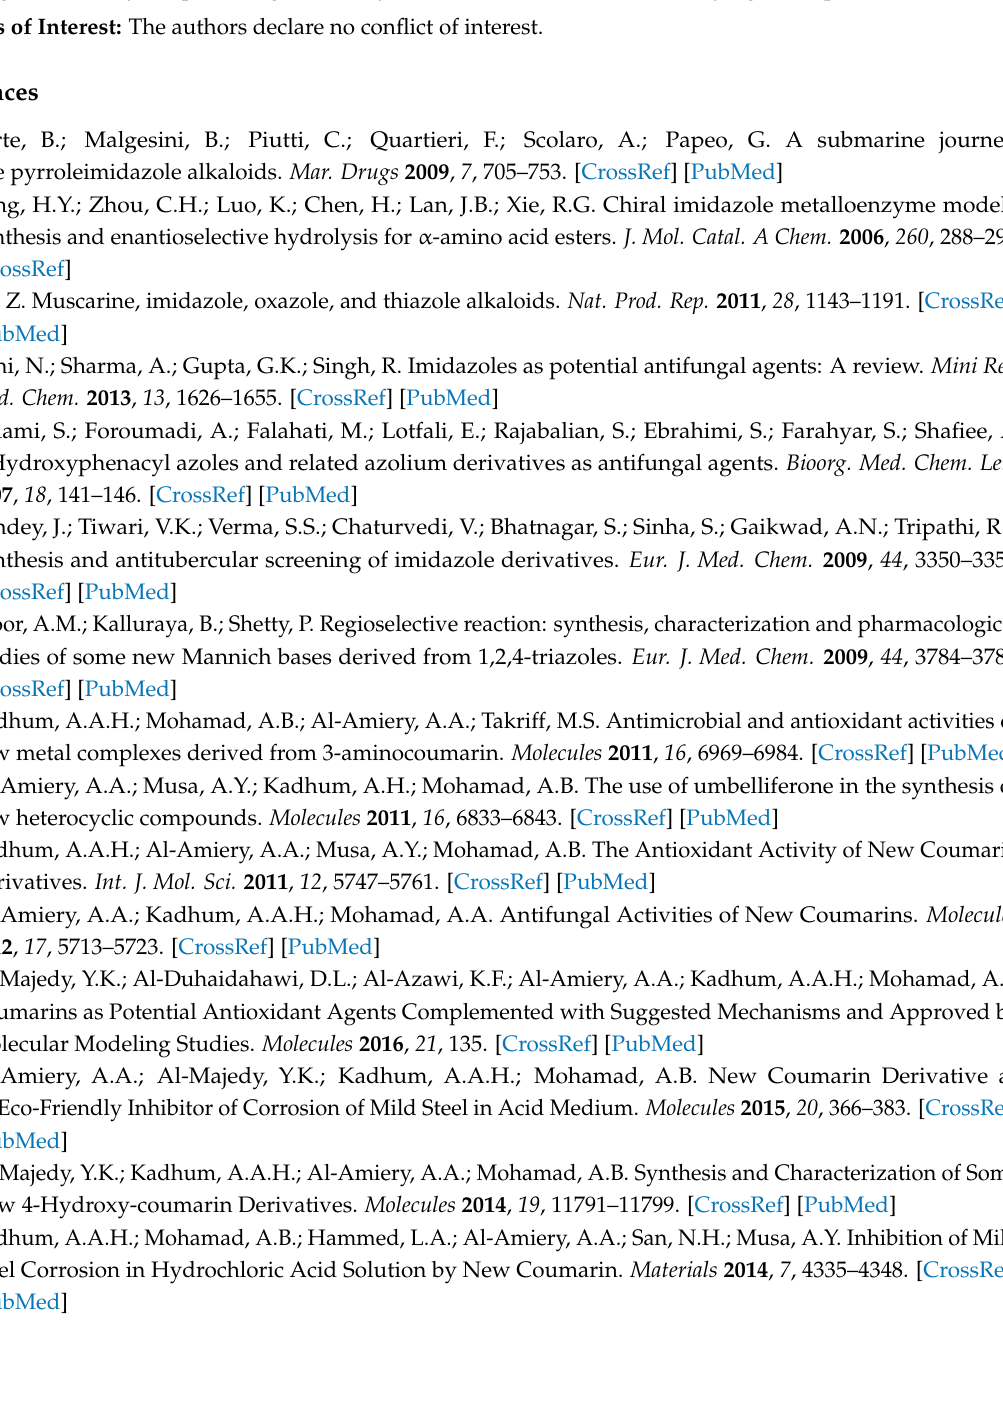
Supplementary Materials: The following are available online, Figure S1: HPLC, Figure S2: MS, Figure S3: 13 C-NMR, Figure S4: DEPT, Figure S5: 1